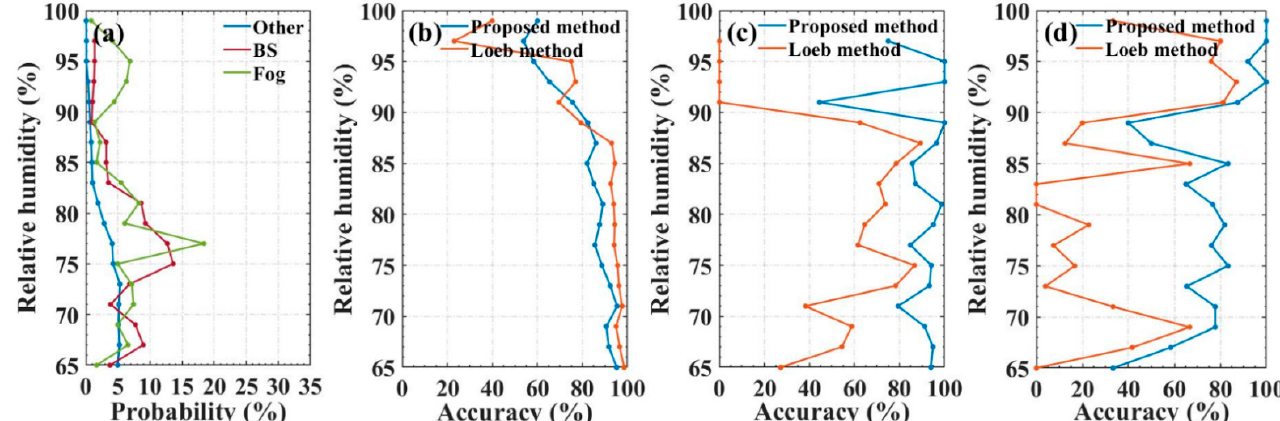
Figure 9. ( a ) The distribution proportion of other situations, blowing snow and fog under different relative humidities. The accuracy of the proposed algorithm and Loeb method for classifying ( b ) other situations, ( c ) blowing snow and ( d ) fog under different relative humidities.